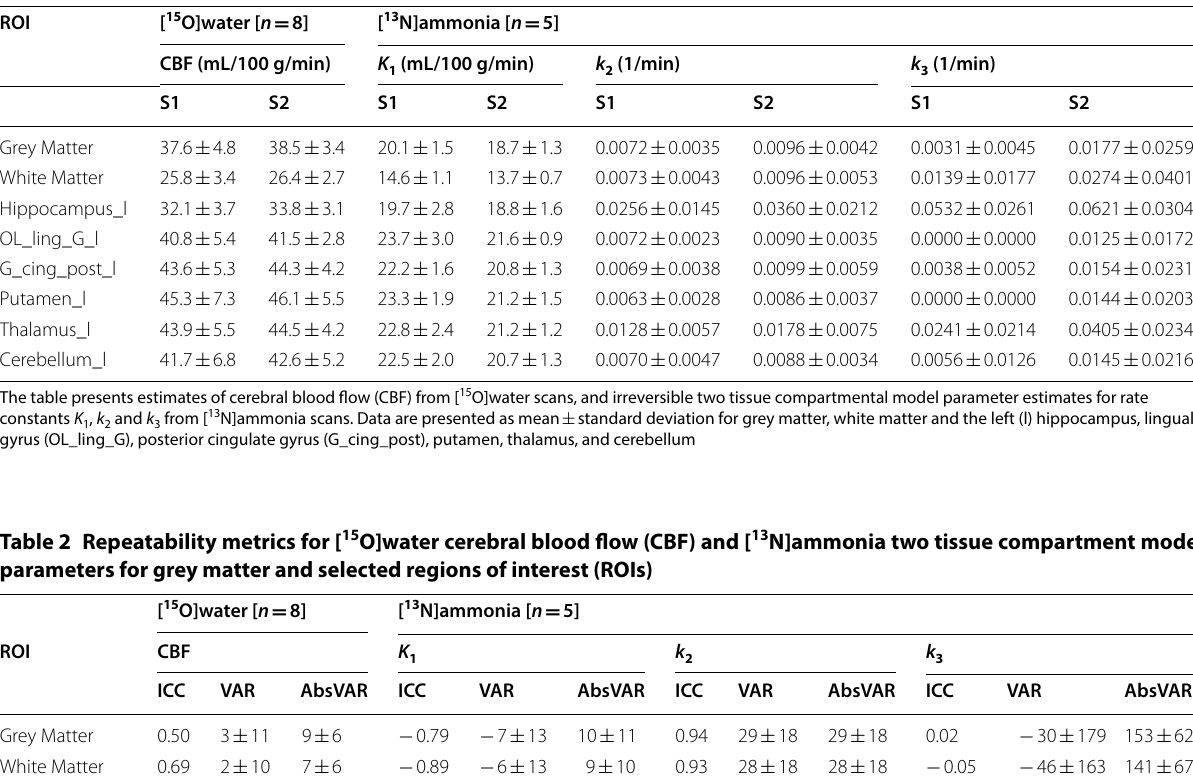
Table 1 Model parameters for test (S1) and retest (S2) scans for grey matter and selected regions of interest (ROIs)